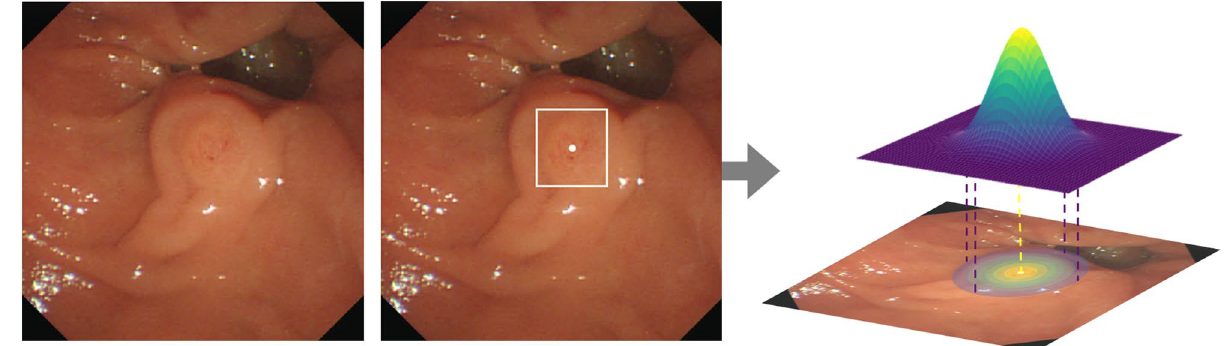
Figure 1. An example of an endoscopic image (left), its original bbox annotation (middle), transformed pixel- wise soft mask label (right). The centroid of the bbox is marked as a dot. For labels (middle and right), the image was overlapped to visualize the location of them on the